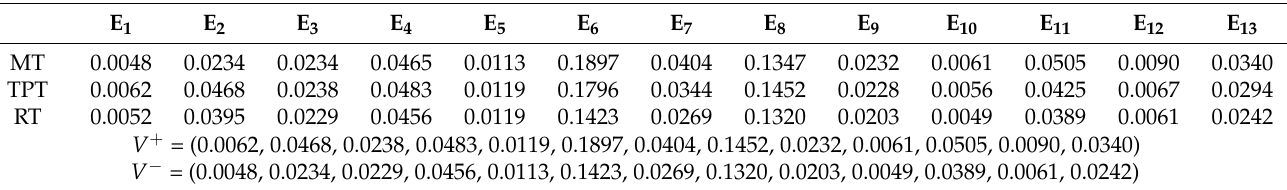
Table 8. Weighted normalized matrix.